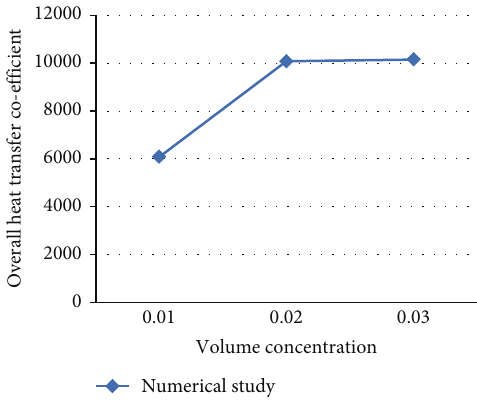
Figure 11: Variation of overall heat transfer coe ffi cient with mass fl ow rate for 1% alumina.